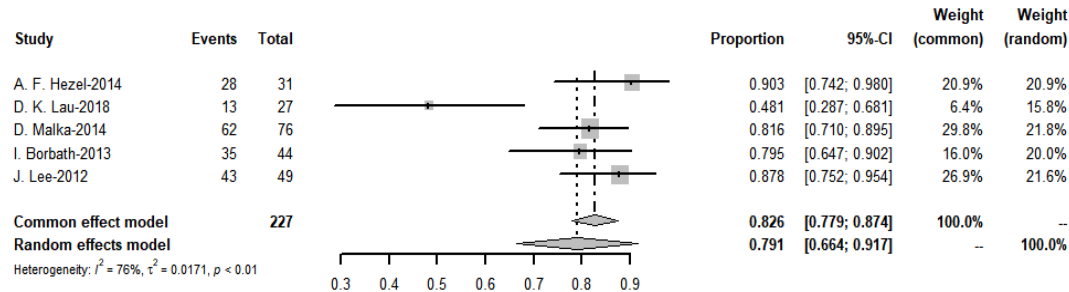
Figure 21. Disease control rate of immunotherapies and funnel plot. Figure 20. Disease control rate of targeted therapies and funnel plot. Figure 20. Disease control rate of targeted therapies and funnel plot.